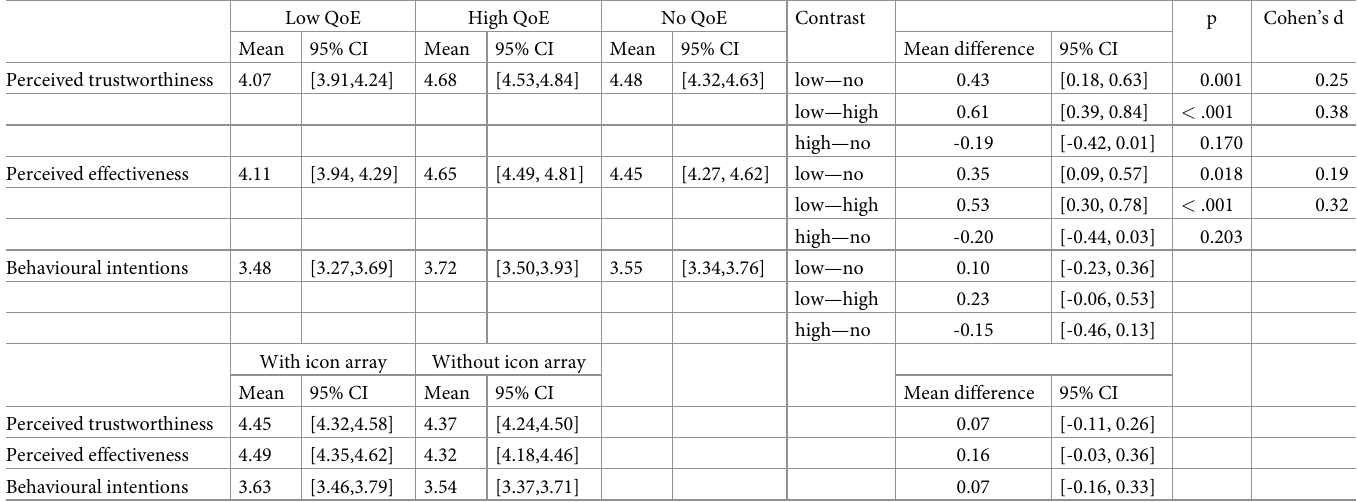
Table 8. Post hoc results for main effects of quality of evidence level and presentation format (Experiment